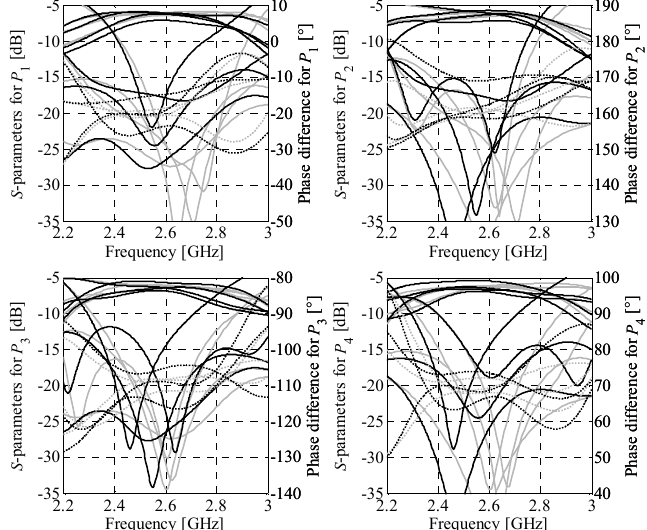
Figure 13. Butler matrix 2: comparison of the EM model responses obtained using CST Studio (gray) and Keysight ADS (black). Solid and dotted lines represent magnitude and phase responses, respectively.